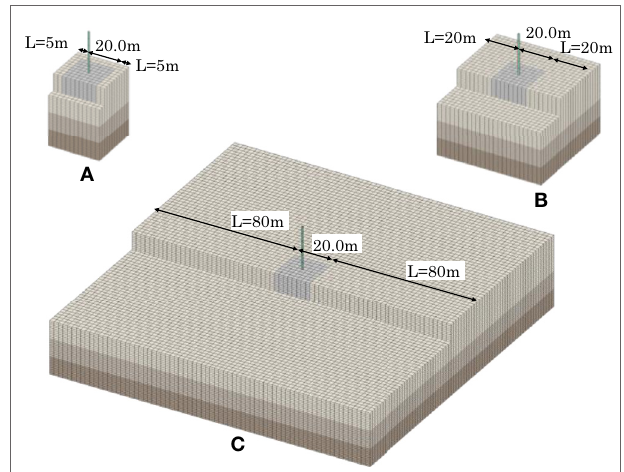
FigUre 16 | comparison of analysis model [(a) L = 5 m, (B) L = 20 m, and (c) L = 80 m] .